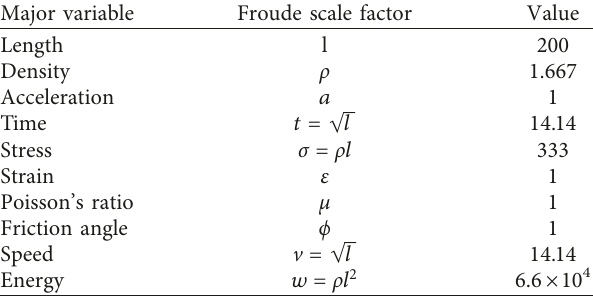
Table 1: Scale factors and values of the major variables.